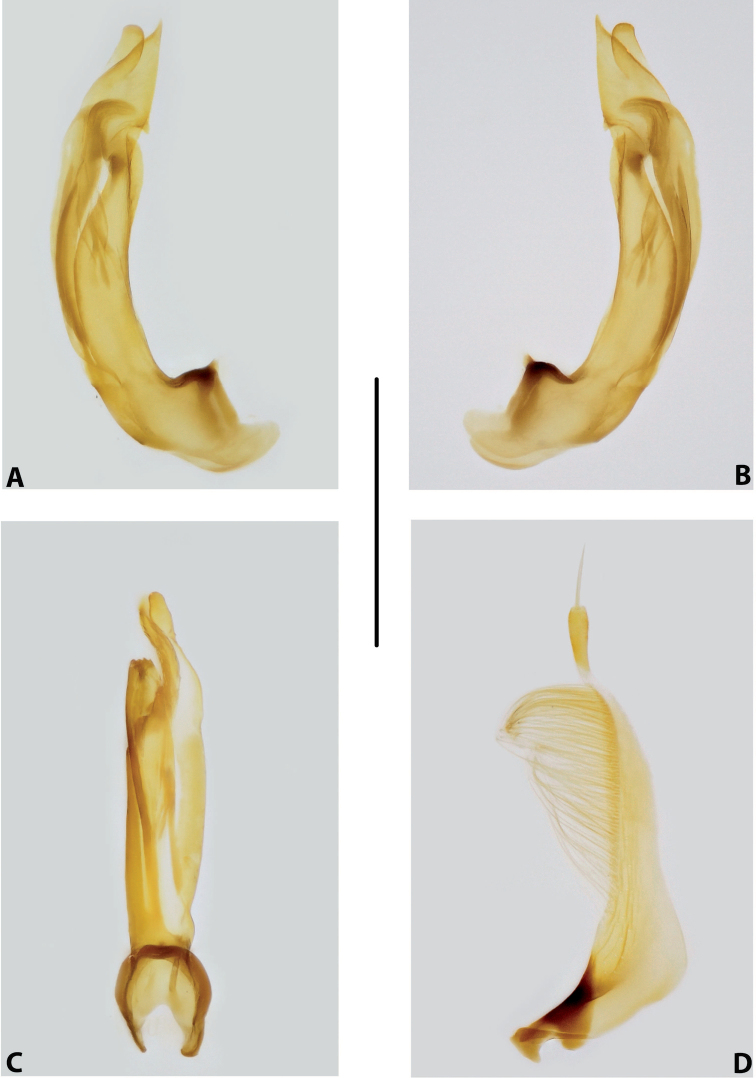
Copelatus
nigrolineatusA median lobe in lateral view, right side B median lobe in lateral view, left side C median lobe in ventral view D left paramere in external view. Scale bar: 0.5 mm.